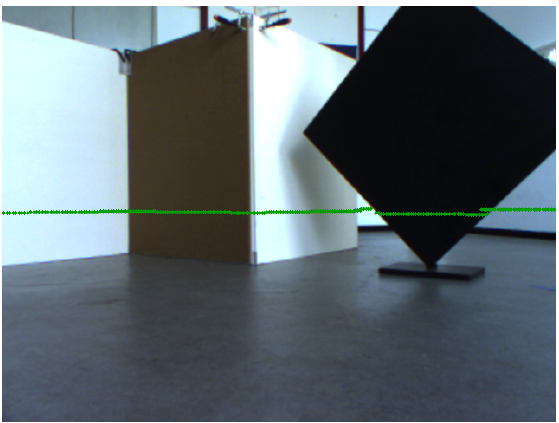
Figure 10. Laser projection into the monocular camera of the MAV.